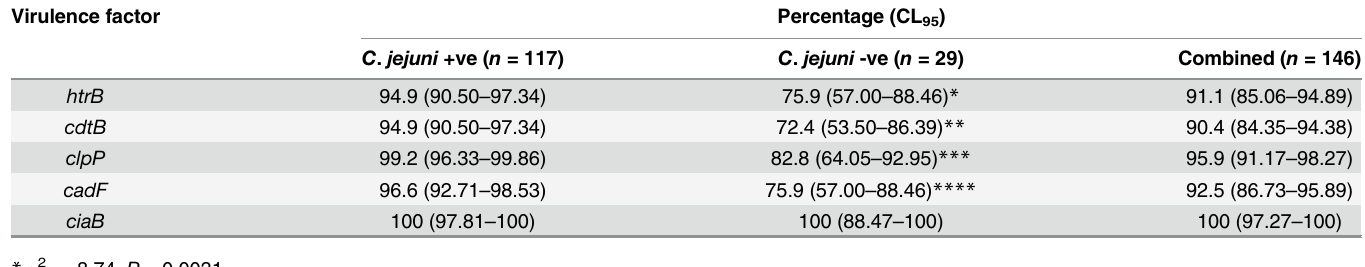
Table 2. Presence of 5 virulence factors in colonies grown in Karmali medium that were either positive or negative for C . jejuni , and combined. Virulence factor Percentage (CL 95